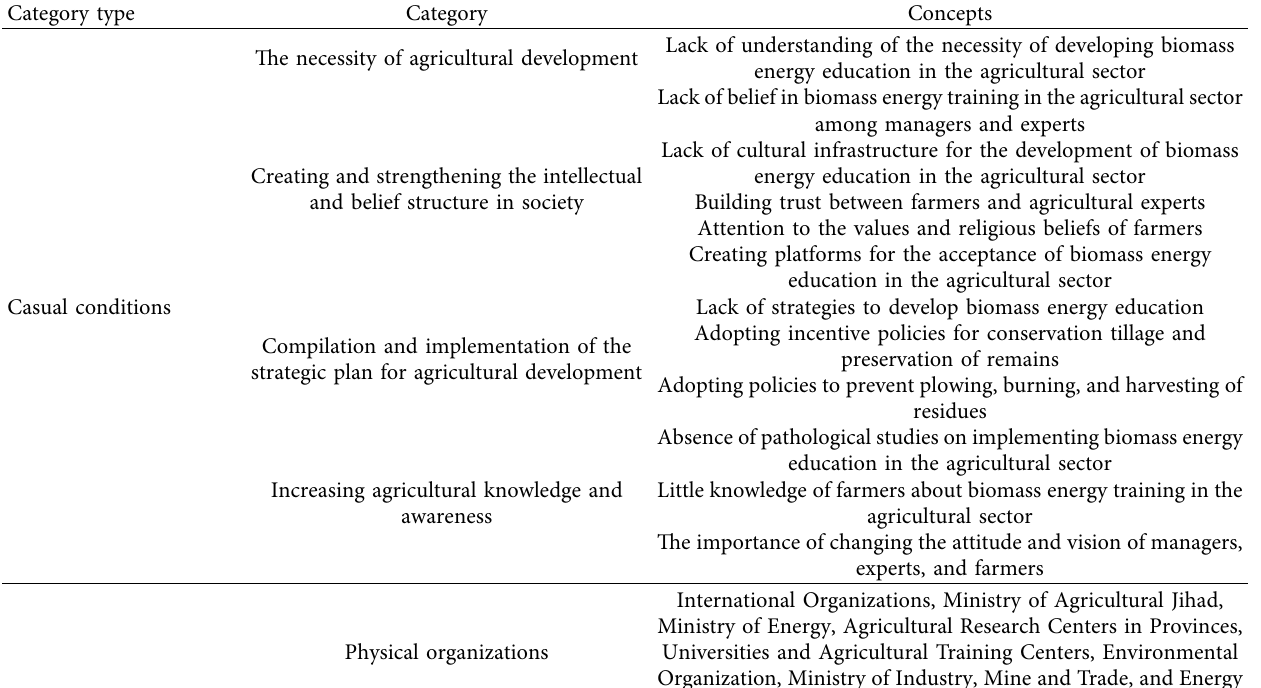
Table 4: Selective coding